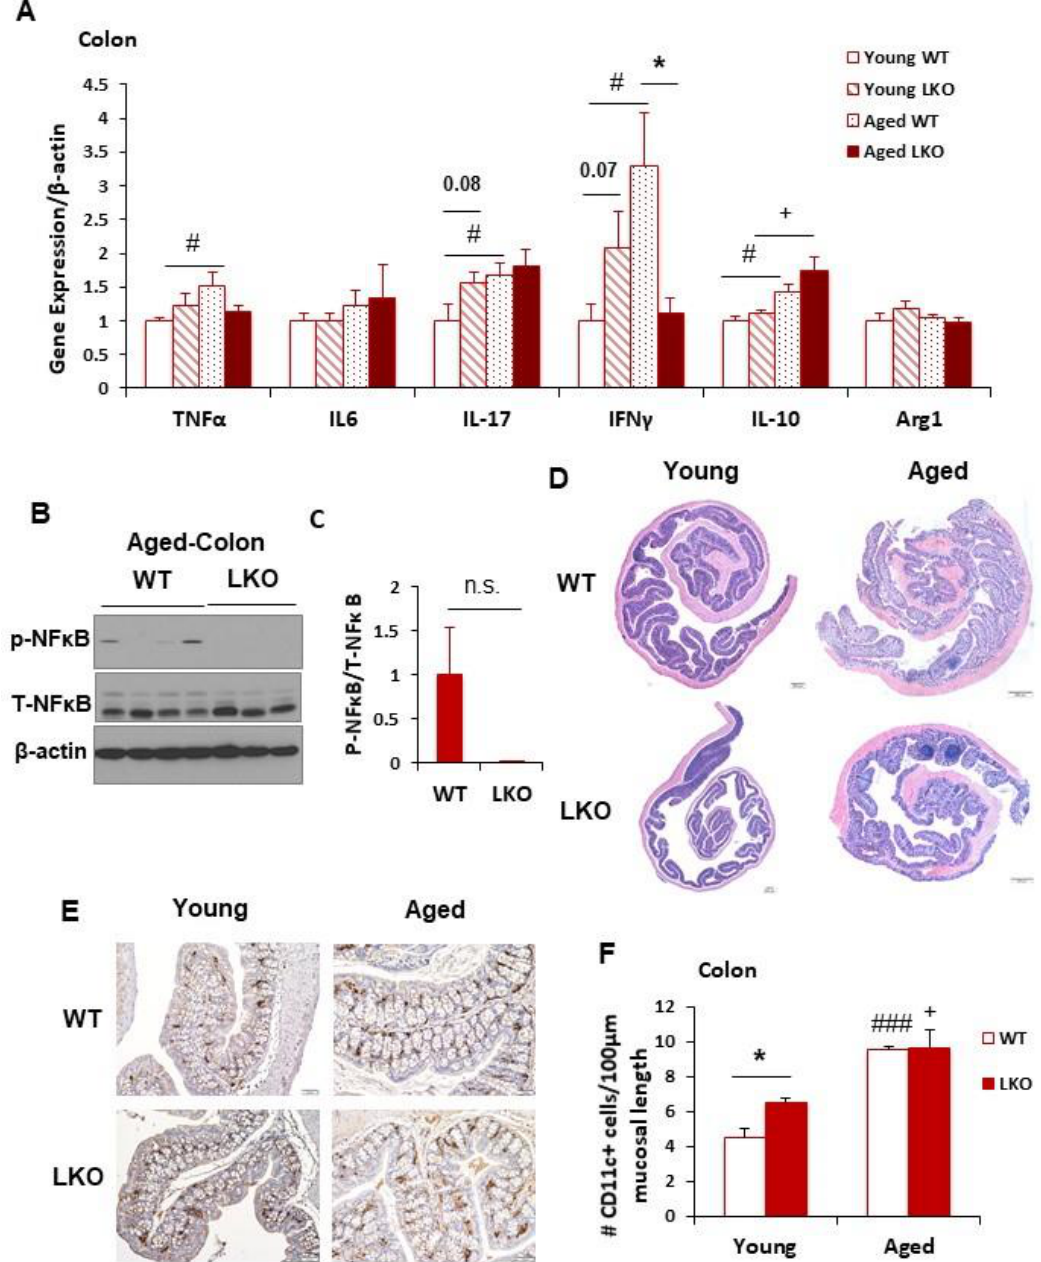
Figure 4. Lcn2 deficiency has no effect on intestinal inflammation during aging. RCD-fed male mice were euthanized at the ages of 6 months (young) and 18 months (old). ( A ) qPCR was performed to compare the mRNA expression levels of pro- and anti-inflammatory cytokines in the colon between WT and LKO mice. The results are presented as mean ± SEM (n = 5–9). ( B , C ) Colon tissues were homogenized and lysed in RIPA buffer for the examination of phospho-(S536)-NF κ B and total NF κ B levels between old WT and old LKO mice by Western blotting ( B ) and quantified by ImageJ ( C ). ( D ) H&E staining of colons from young and old WT and LKO mice. Scale bars = 200 µ m, × 200. ( E , F ) Immunohistochemistry of CD11c on paraffin-embedded colon sections from young and old WT and LKO male mice. ( E ) Representative images of CD11c-stained colon sections, scale bars = 50 µ m, × 200. ( F ) Results were quantified by counting the number of CD11c + cells and measuring the mucosal length. Data are presented as mean ± SEM (n = 3) of the number of CD11c + cells per 100 µ m of mucosal length. * p < 0.05 versus WT mice. # p < 0.05, ### p < 0.001 versus young WT mice. + p < 0.05 versus young LKO